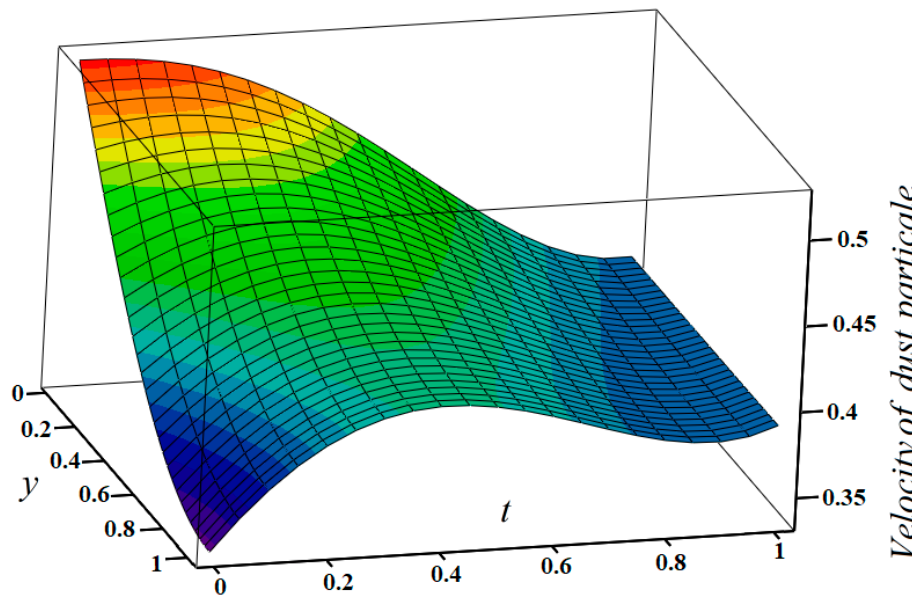
Figure 12. 3D plot of dust particle velocity.